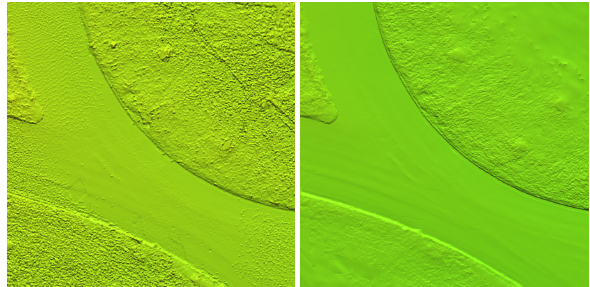
Figure 6. Comparison of DTMs generated without alignment (left) and with alignment